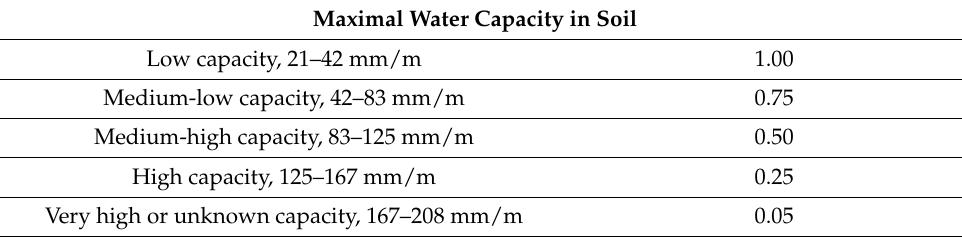
Table 5. Geological–hydrological category “Maximal water capacity in soil” with probability values.